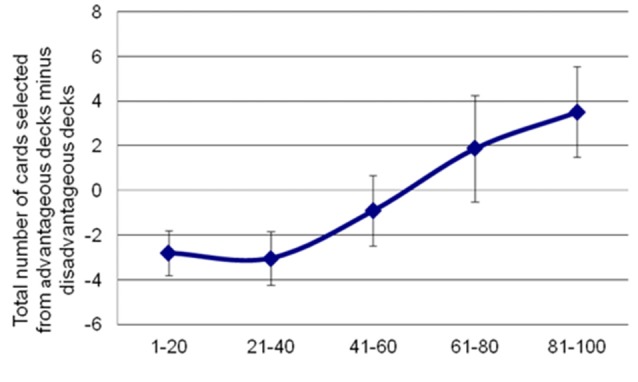
Participants’ performance in the IGT along the 100 trials. Net scores were calculated by subtracting the number of advantageous choices from the number of disadvantageous ones. Error bars represent the standard error of the mean.